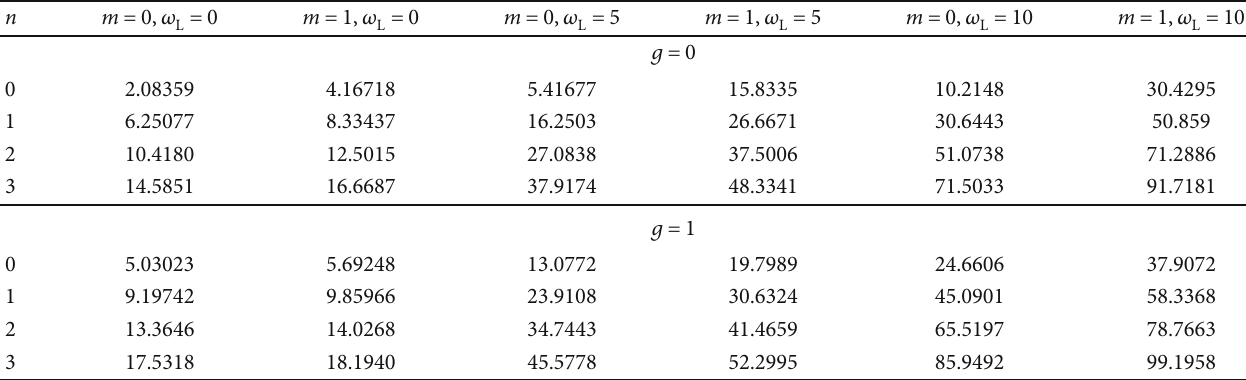
Table 5: Energy spectra for I molecules bounded by the isotropic oscillator plus inverse quadratic potential for arbitrary Larmor 2 frequencies ω L